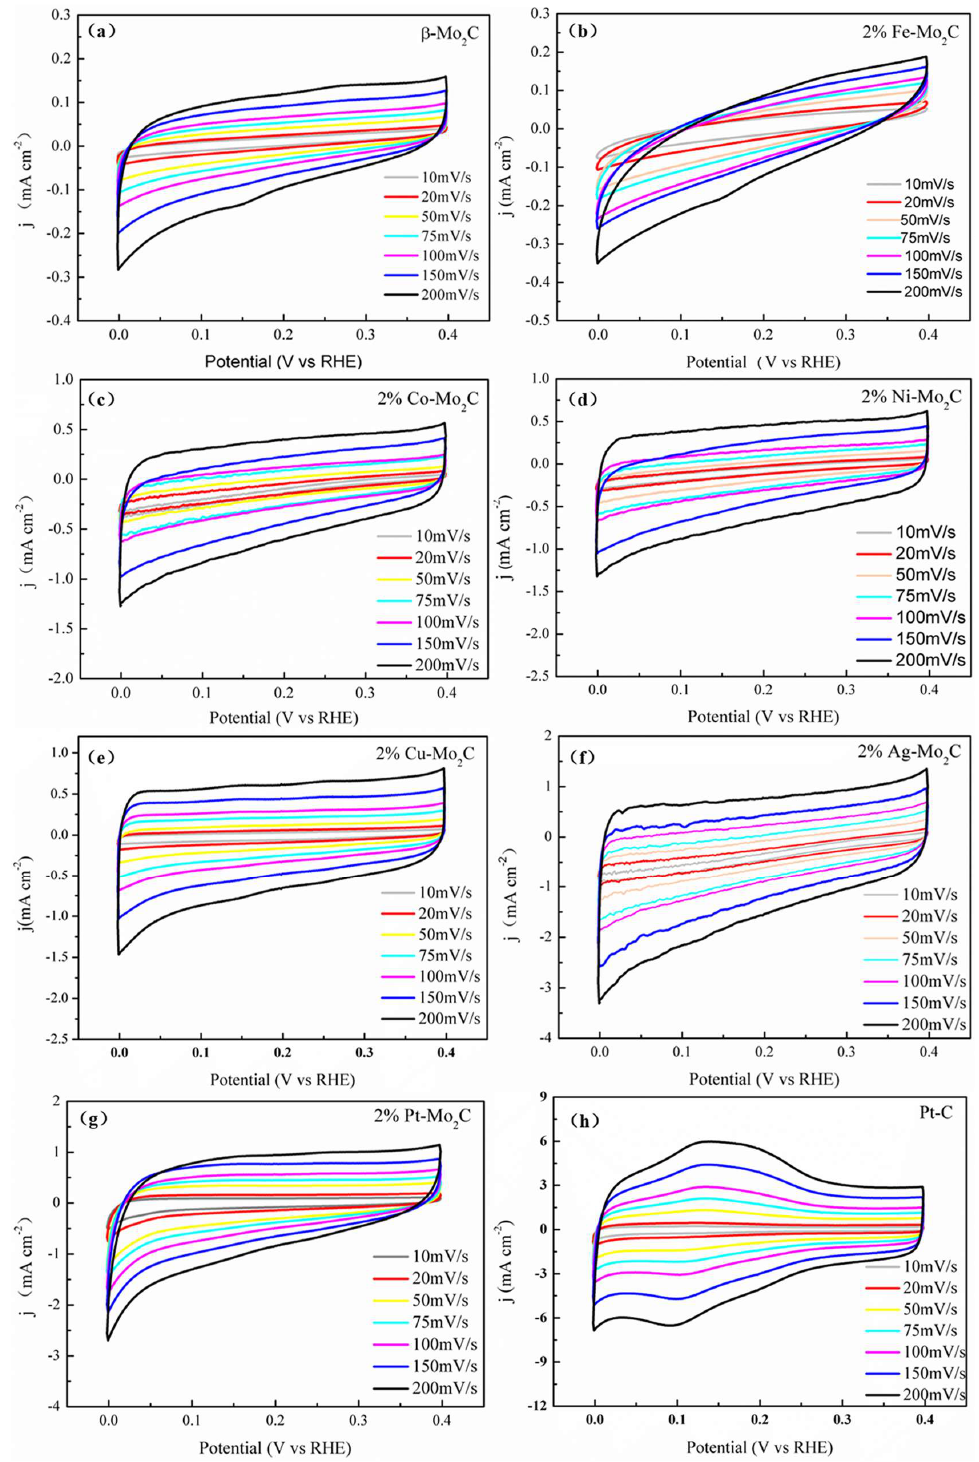
Figure 6. Cyclic voltammograms of ( a ) β-Mo 2 C, ( b ) 2% Fe-Mo 2 C; ( c ) 2% Co-Mo 2 C; ( d ) 2% Ni-Mo 2 C; ( e ) 2% Cu-Mo 2 C; ( f ) 2% Ag-Mo 2 C; ( g ) 2% Pt-Mo 2 C and ( h ) commercial Pt/C with various scan rates in 0.5 M H 2 SO 4 .